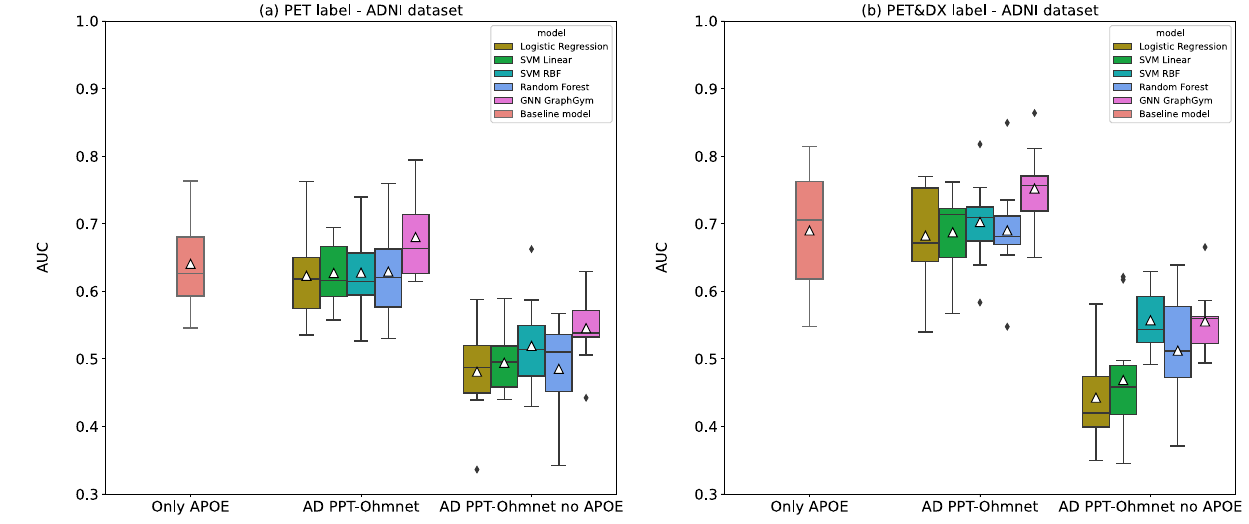
Figure 3. Boxplots showing the AUC distribution values of different models on the test set using as targets either ( a ) PET, or ( b ) PET&DX. Red boxplots (labeled as “Only APOE”) correspond to the baseline models. White triangles ( △ ) represent mean AUC